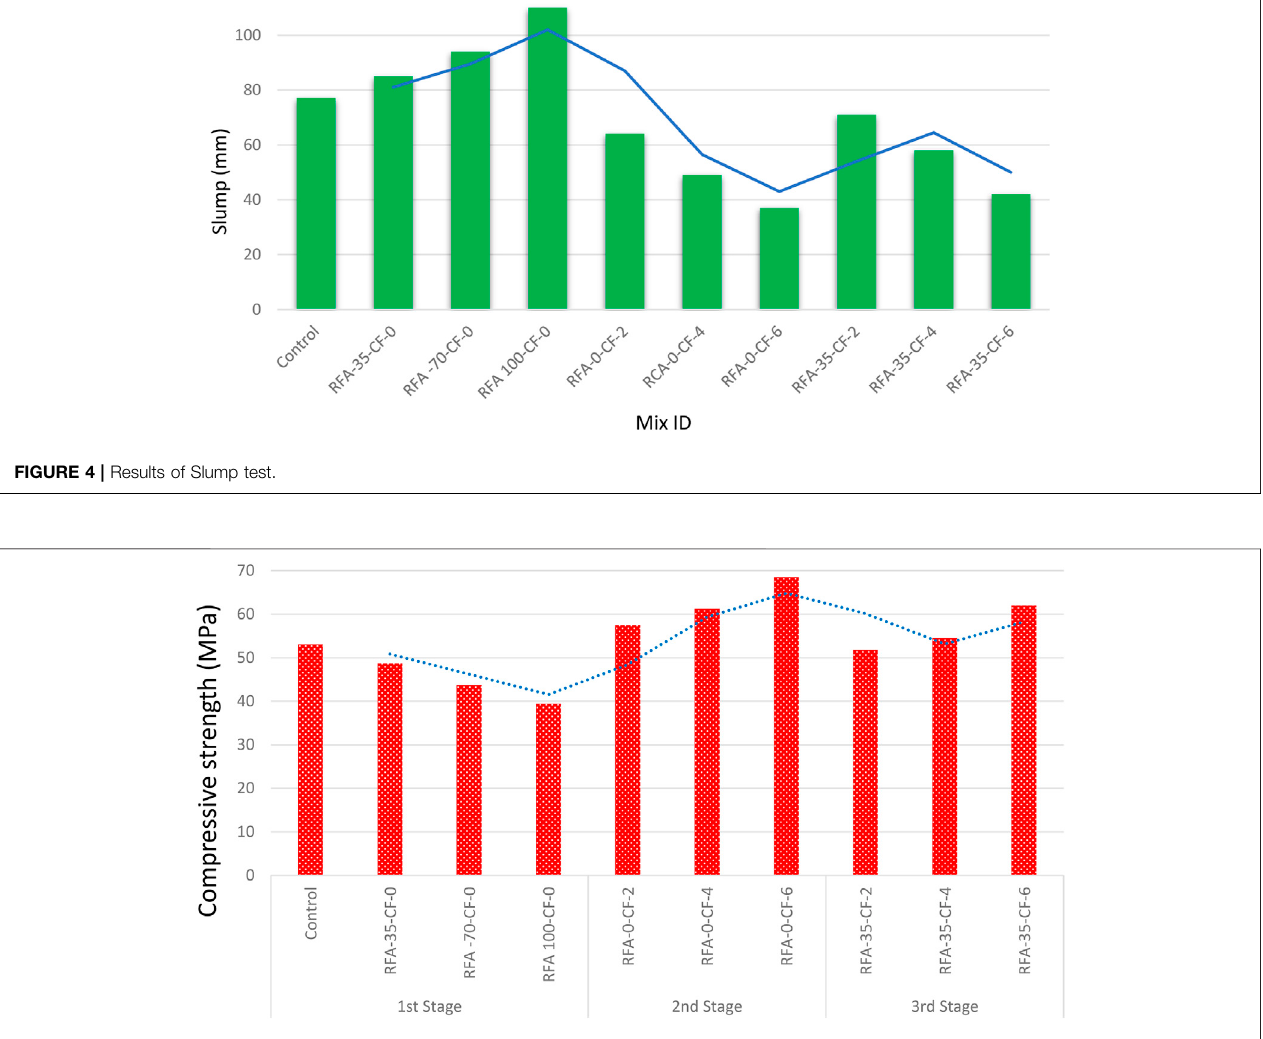
FIGURE 5 | Compressive strength of all concrete samples at 28 days.